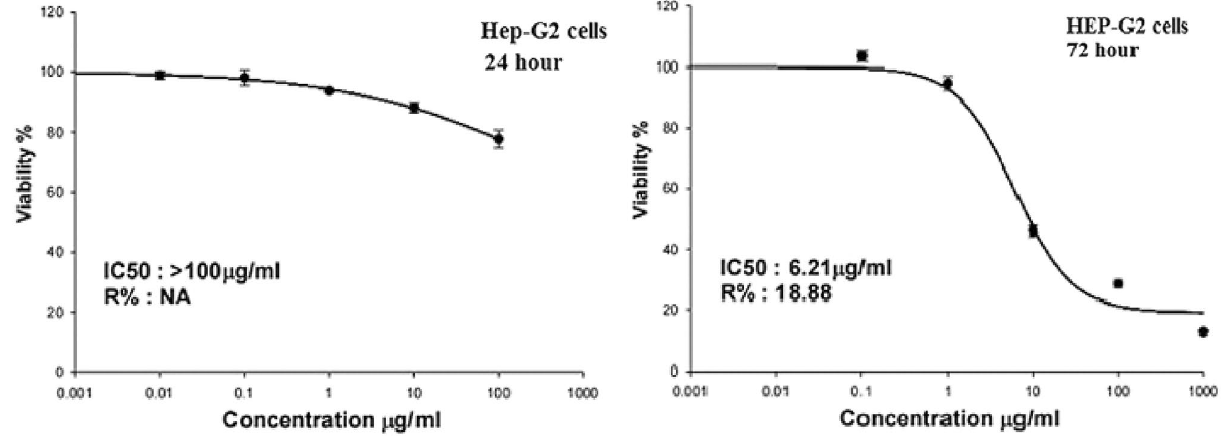
Figure 4. Viability of Hep-G2 cells after exposure to different concentrations of Erbium Oxide nanoparticles for 24 or 72 h.